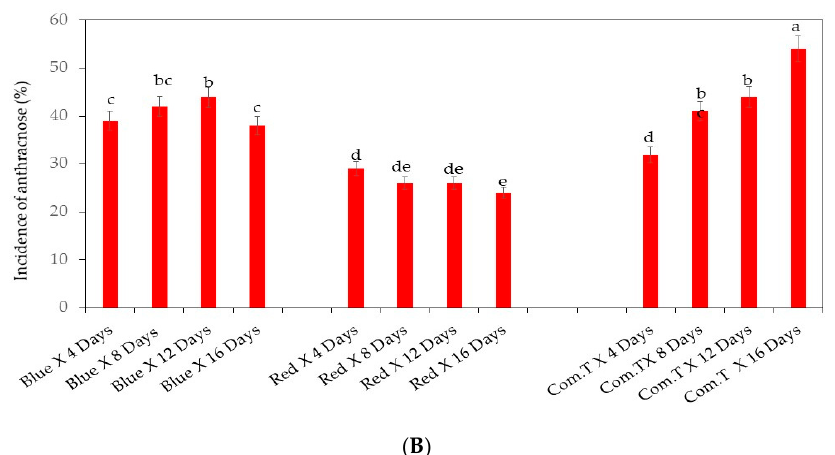
Figure 1. ( A ) Influence of light-emitting diode (LED) light exposure on inoculated avocado cultivar Fuerte. ( B ) Influence of LED light exposure on inoculated avocado cultivar Hass. The exposure of the fruit to blue or red LED light was for 6 h per day during storage. Ten replicate tray packs, each containing four fruit, underwent different postharvest treatments. Mean values of bars marked by different letters were significantly different at p < 0.05, according to Fisher’s protected LSD test. Blue, blue LED light; Red, red LED light; Com.T, commercial treatment.